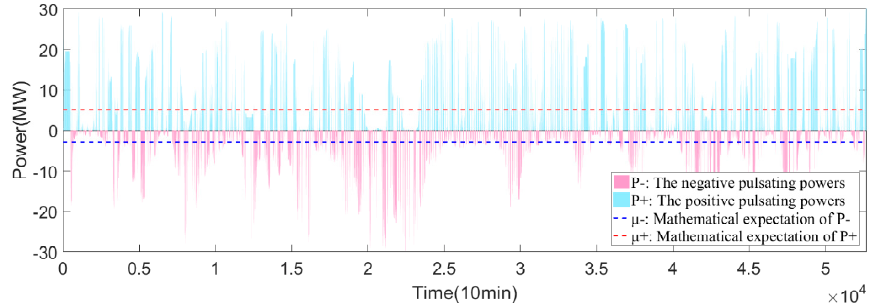
Figure 3. The distribution map of positive and negative pulsating